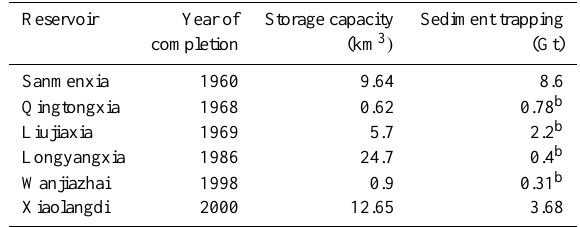
Table 2. Sediment retention within the major mainstem reservoirs a